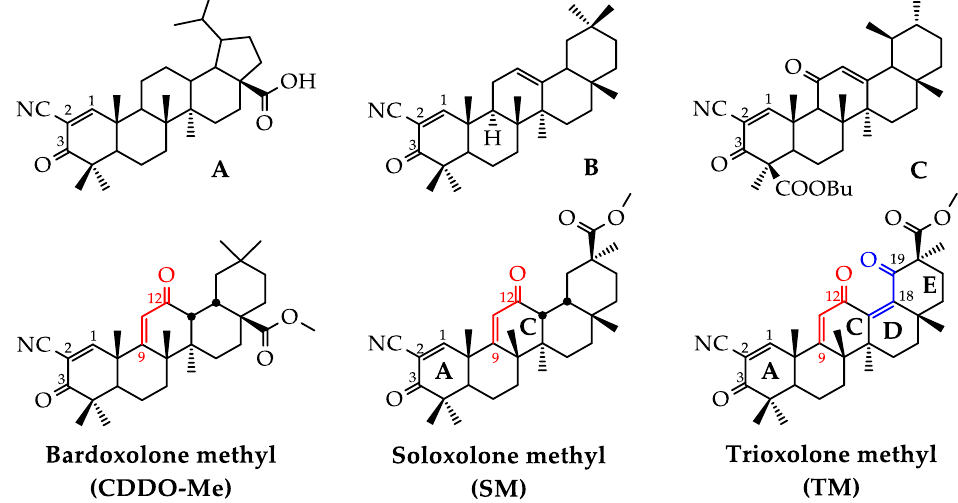
Figure 1. The chemical structures of cyano enone-bearing semi-synthetic triterpenoids.